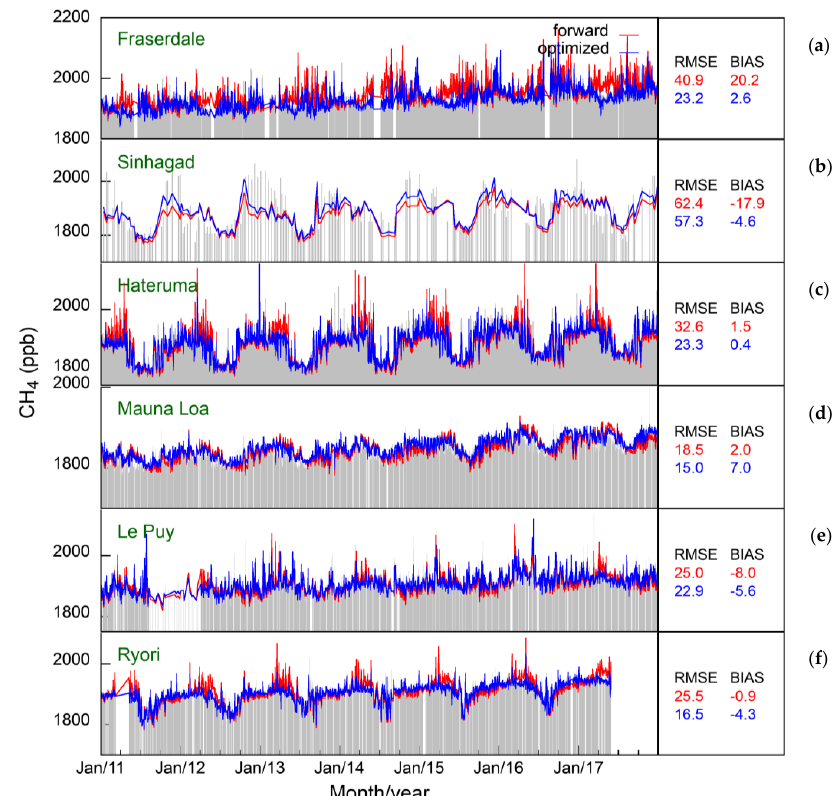
Figure 2. The observed (grey impulses), prior forward (red), and optimized (blue) CH 4 concentrations at six sites, ( a ) Fraserdale, ( b ) Sinhagad, ( c ) Hateruma, ( d ) Maunaloa, ( e ) Le Puy, and ( f ) Ryori. The root mean squared error (RMSE, in ppb) and the bias (BIAS, in ppb) for the prior and posterior are shown (red and blue, respectively).